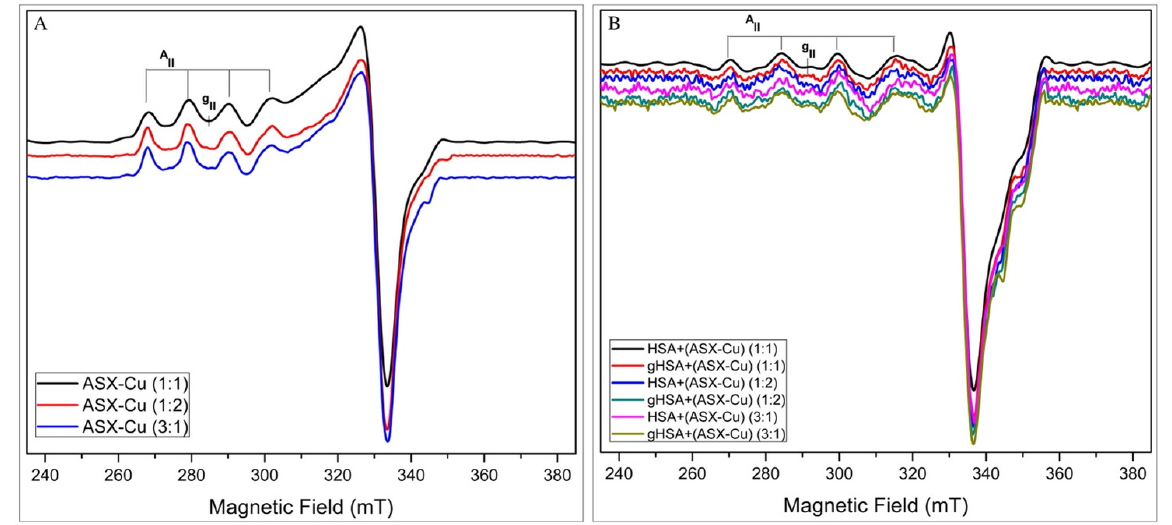
Figure 2. X-band EPR spectra of: ASX-Cu 1:1 (black line), ASX-Cu 1:2 (red line) and ASX-Cu 3:1 (blue line) ( A ). HSA+(ASX-Cu) in the molar ratios: 1:1 (black line), 1:2 (blue line), 3:1 (pink line) and gHSA+(ASX-Cu) in the molar ratios: 1:1 (red line), 1:2 (green line), 3:1 (brown line) ( B ). Experimental conditions: T = 150 K, ν = 9.67 GHz, 21 mW microwave power and 0.5 mT modulation amplitude.